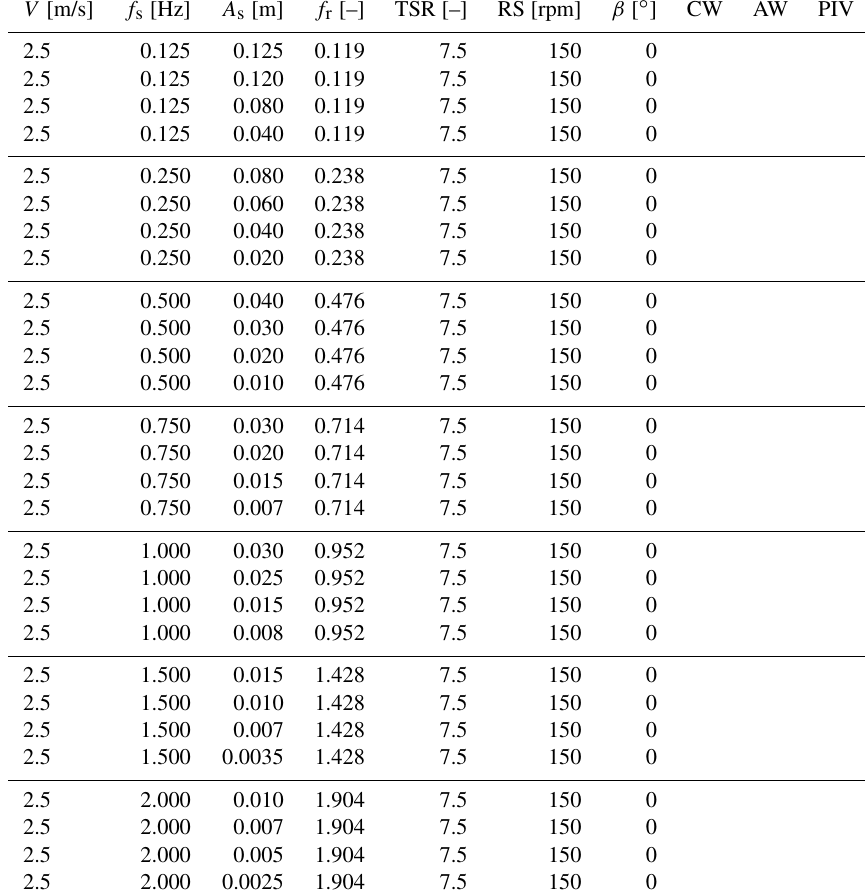
Table B1. RATED1 test matrix. V is the mean wind speed, f s the surge frequency, A s the surge amplitude, f r the reduced frequency, TSR tip-speed ratio, RS the rotor speed, and β the blade pitch angle. The CW, AW, and PIV columns indicate whether a cross-wind, along-wind, or PIV measurement of the wake was carried